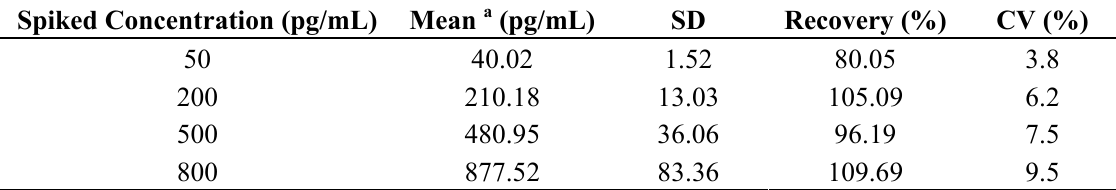
Table 2. Recovery and precision of FLPL-BSAS-mAb1 based LFIA spiked in flour sample (n = 5). Spiked Concentration